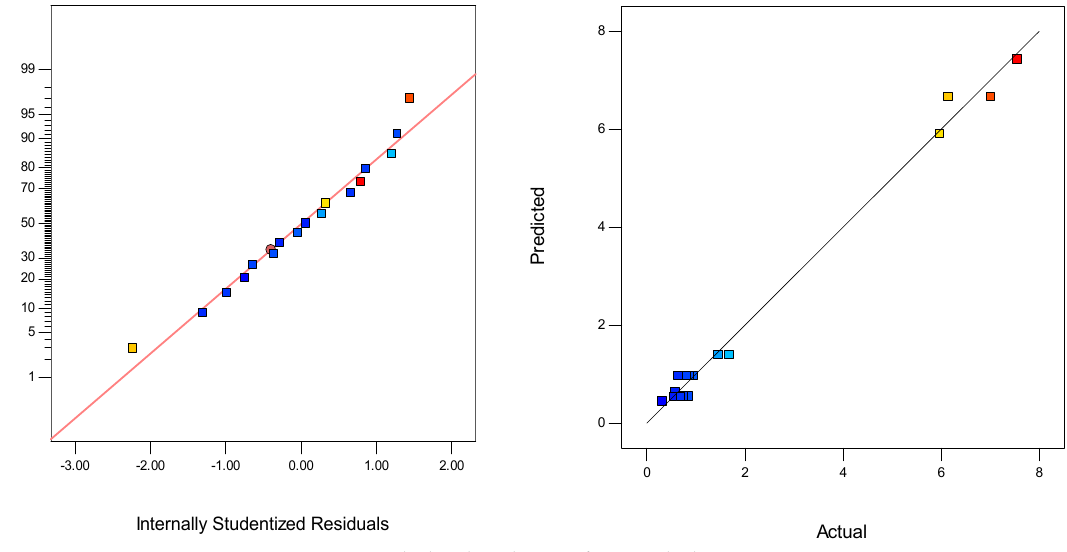
( a ) Normal plot distribution for weight loss.